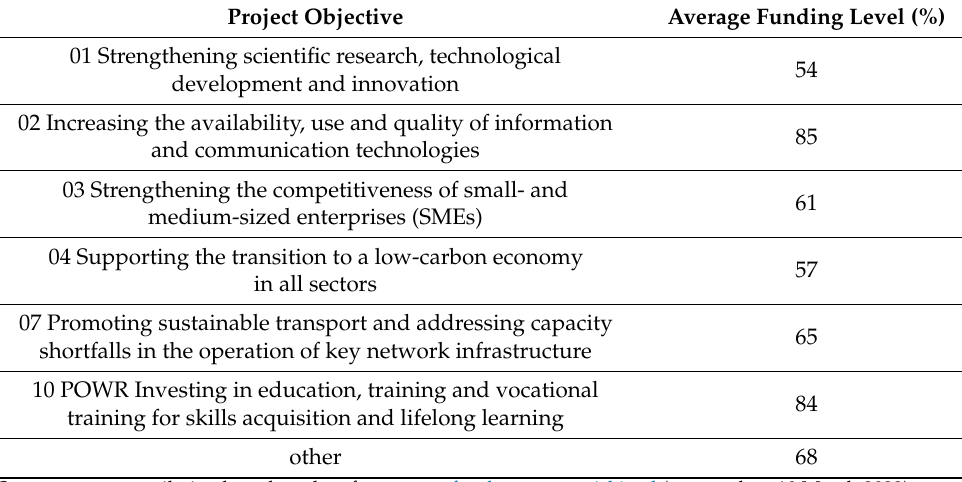
Table 4. Average level of project funding by project purpose.